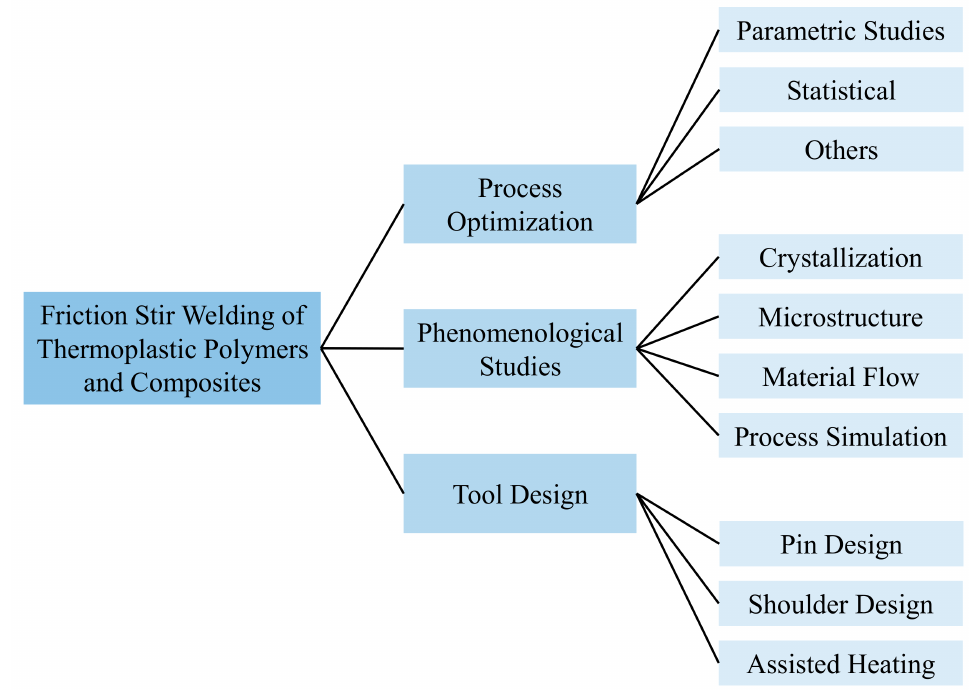
Figure 2. Classification of available